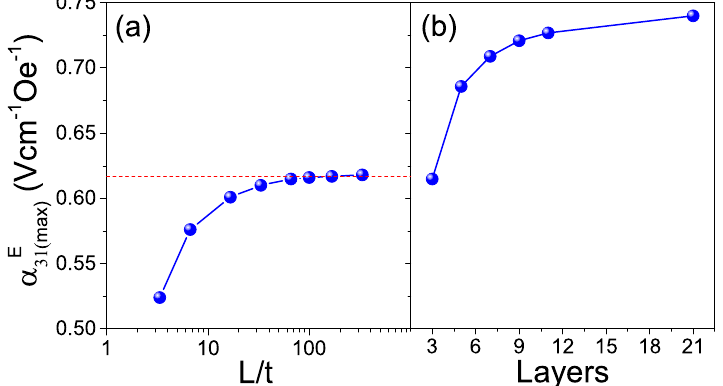
Figure 11. Maximum transverse ME coefficient α E 31(max) , simulated in 2D, as a function of (a) the ratio between length L and thickness t of three-layer composites CFM25/L4.0Ta15/CFM25; and (b) the number of layers for composites with L/t=66, piezoelectric phase L4.0Ta15 and magnetostrictive phase CFM25, which always have the external faces constituted by the magnetostrictive